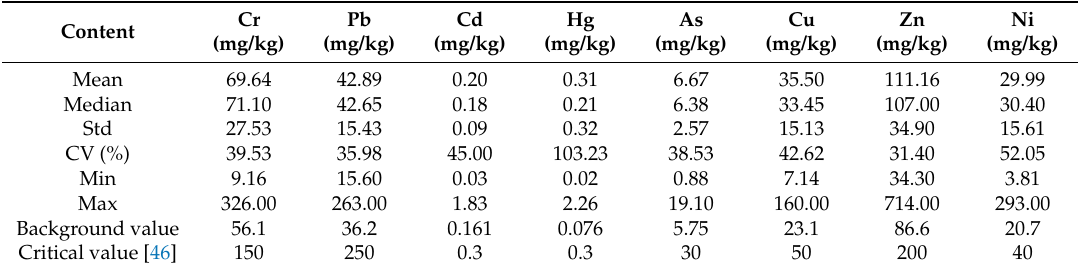
Table 4. Summary statistics of the heavy metal contents in soil ( N =